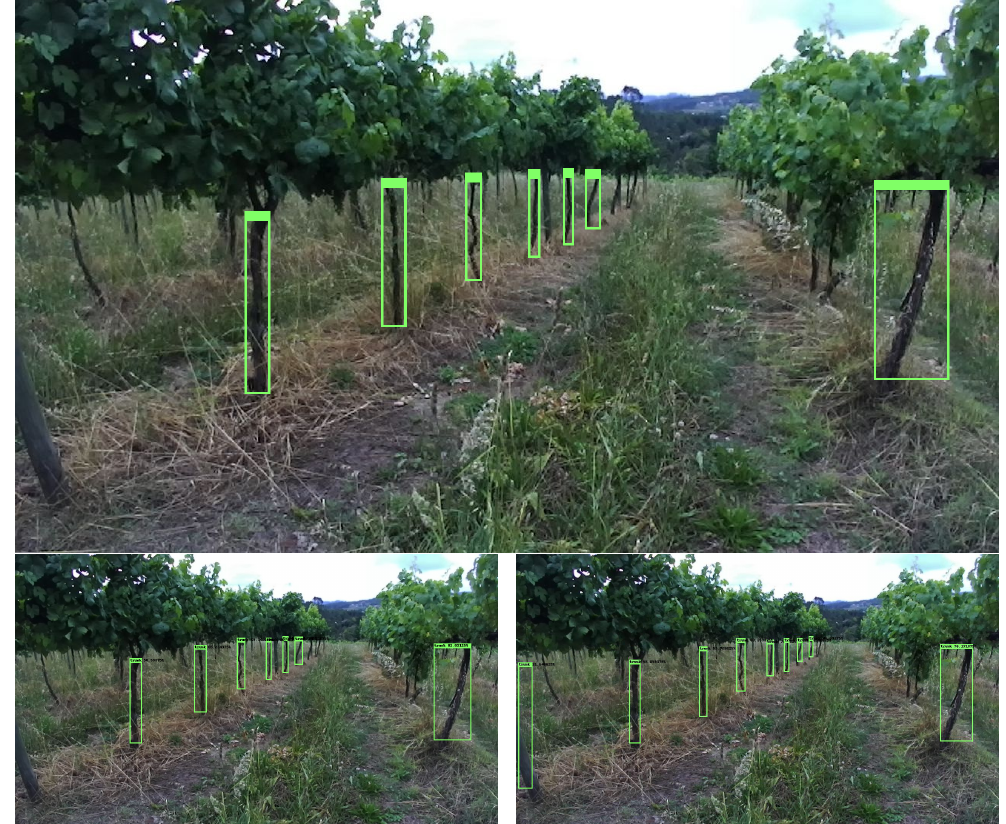
Figure 13. Detection results of the trained models with and without enhanced images in the training dataset. Top image: ground truth, bottom left: Model trained with enhanced images, bottom right: Model trained without enhanced